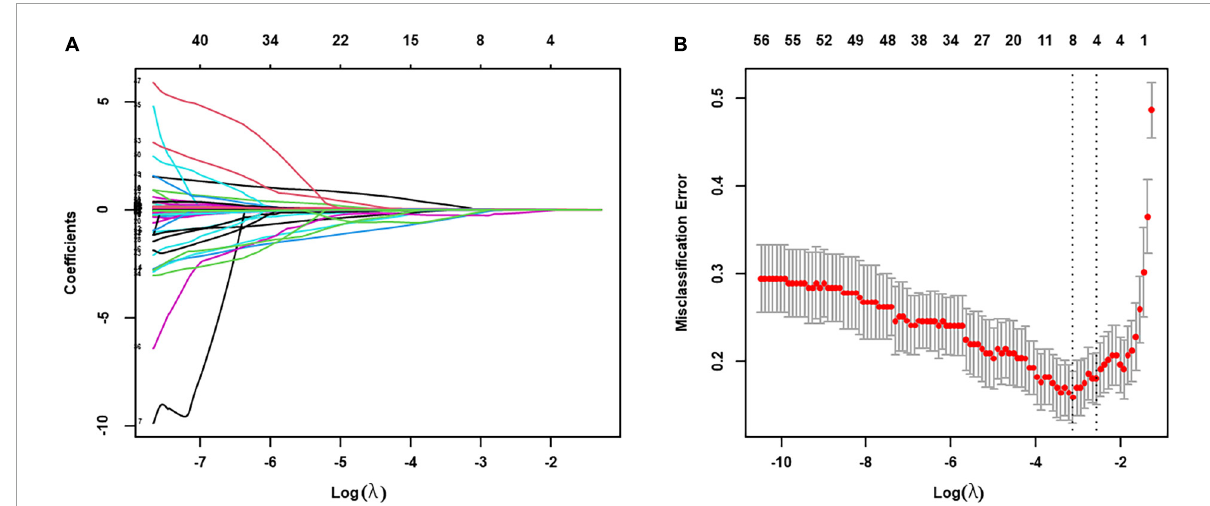
FIGURE3 LASSO regression was used to select the relevant factors for AF persistency. (A) LASSO coefficient curves for the 62 clinical variables; (B) tuning parameter ( λ ) selection in the LASSO model used 10-fold cross-validation via minimum criteria. The partial likelihood deviance (binomial deviance) curve was plotted vs. log ( λ ). Dotted vertical lines were drawn at the optimal values by using the minimum criteria ( λ value of 0.0438) and the one SE of the minimum criteria (the 1-SE criteria, λ value of 0.0765). The optimal value of λ (the vertical dashed line) for 10-fold cross-validation was used to select optimal variables. LASSO, least absolute shrinkage and selection operator.